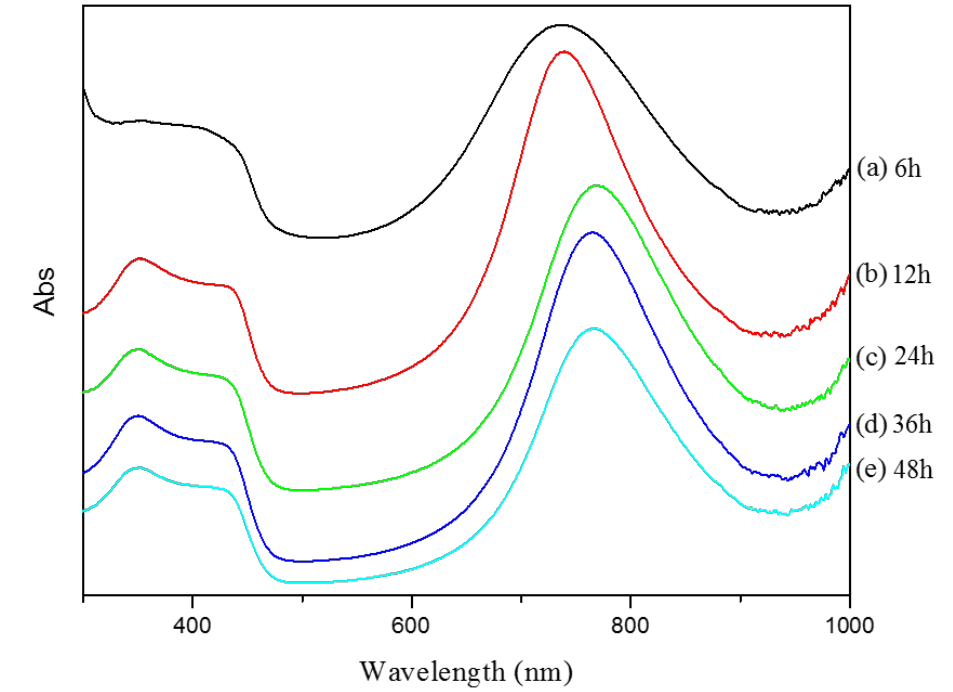
ff erent reaction